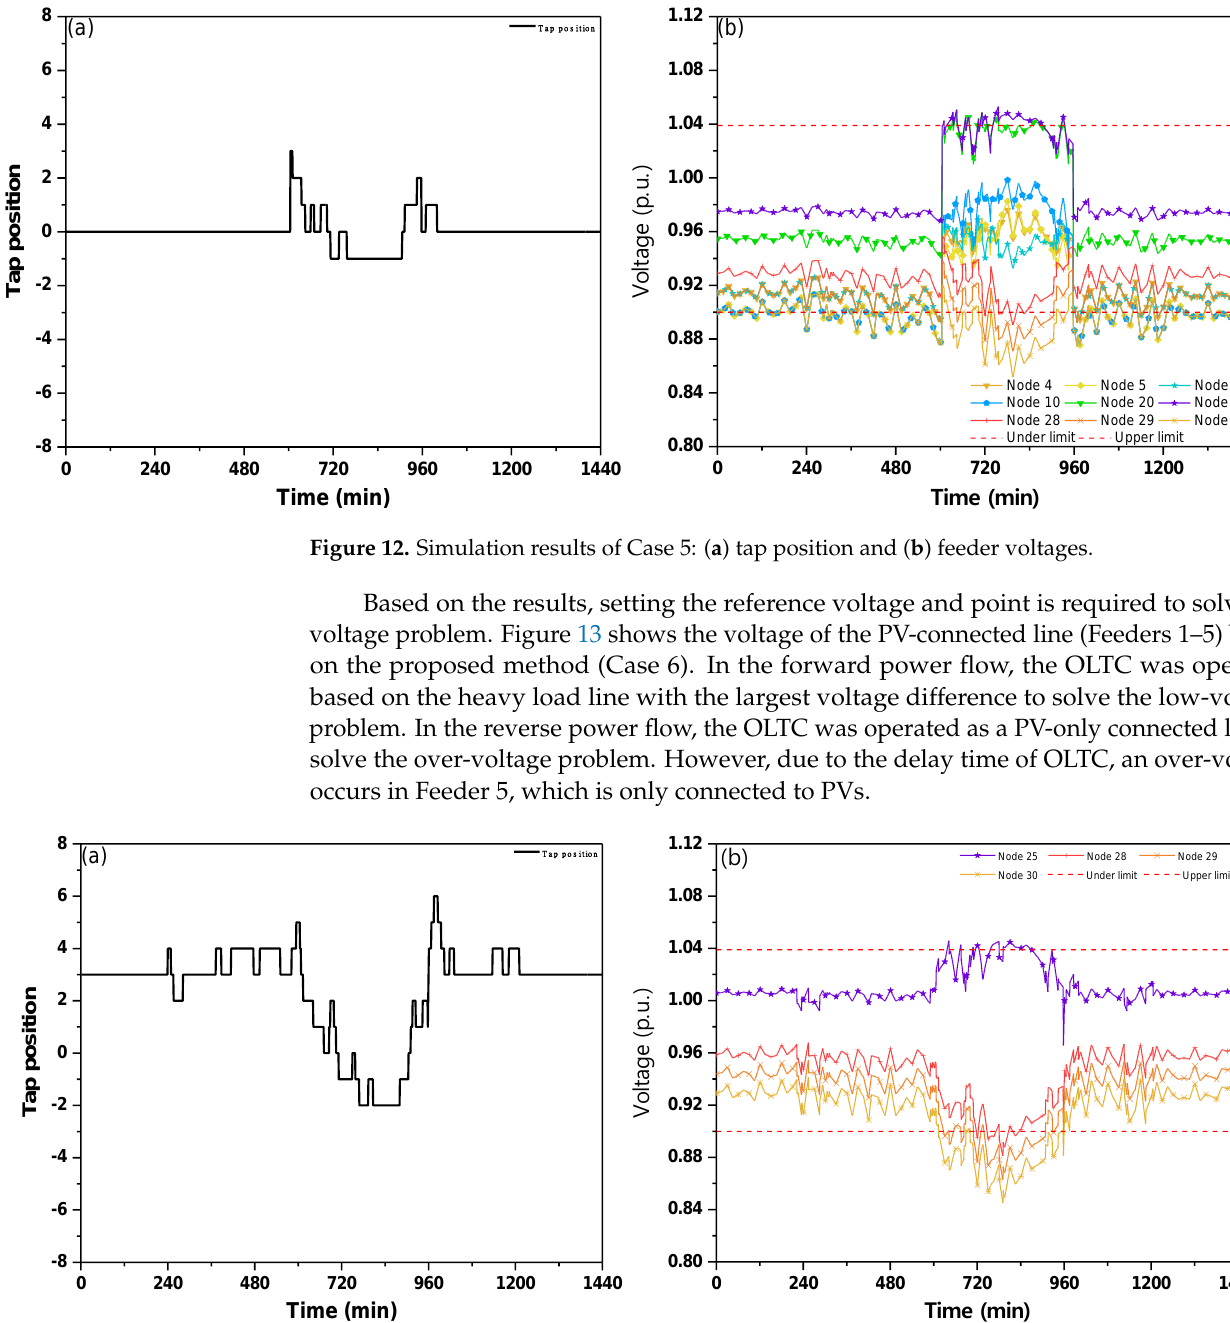
Figure 13. Simulation results of Case 6: ( a ) tap position and ( b ) voltages of the feeders. Table 4 lists the case analysis results. When the OLTC is operated as a heavy load line, the low-voltage problem is solved, but the over-voltage problem worsens. Conversely, when it is operated as a PV line, a low-voltage problem occurs. The proposed method is a suitable combination of the two methods depending on the direction of the power flow, thereby solving the voltage problem most effectively. However, the low-voltage problem in Feeder 6 remained unresolved when a negative tap was applied in the reverse power flow. Table 4. Voltage problem according to the case studies. Voltage Problem Case